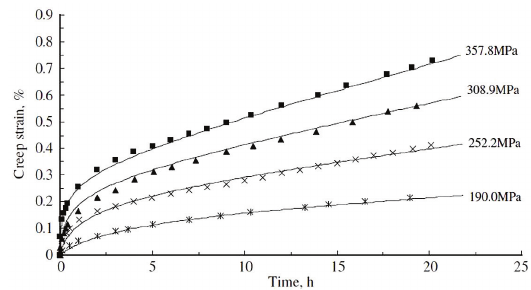
Figure 18. Comparison of experimental (symbols) and computed (solid curves) creep ageing curves for different stress levels - AA7055 at 120C - adapted from 18